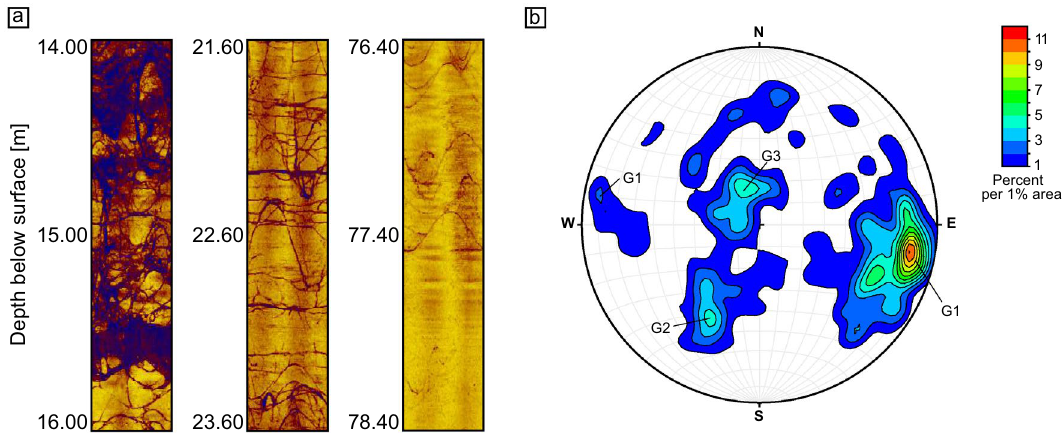
Figure 3. ( a ) Detailed acoustic televiewer images showing different types of fractures, where sinusoidal and planar patterns are mainly attributed to a tectonic origin. Left: Both planar and non-planar intensely branched fractures are forming a network where the rock is subjected to a high degree of weathering. Centre: Planar and non-planar fractures in saprolite of a low weathering degree. Oblique and horizontal planar fractures are intersected. Right: Bedrock featuring neither strong branched nor planar fractures. ( b ) Lower hemisphere stereographic projection illustrating the orientation of fractures as obtained from the televiewer data (poles to fracture planes, n = 283). The fractures can be grouped into three groups, G1, G2, and G3. Group 1 is the dominant group and comprises fractures that are steeply inclined and dominantly strike NNE-SSW. Groups 2 and 3 comprise gently to moderately inclined fractures that strike NW–SE. Data plotted with OSXStereonet 62 .